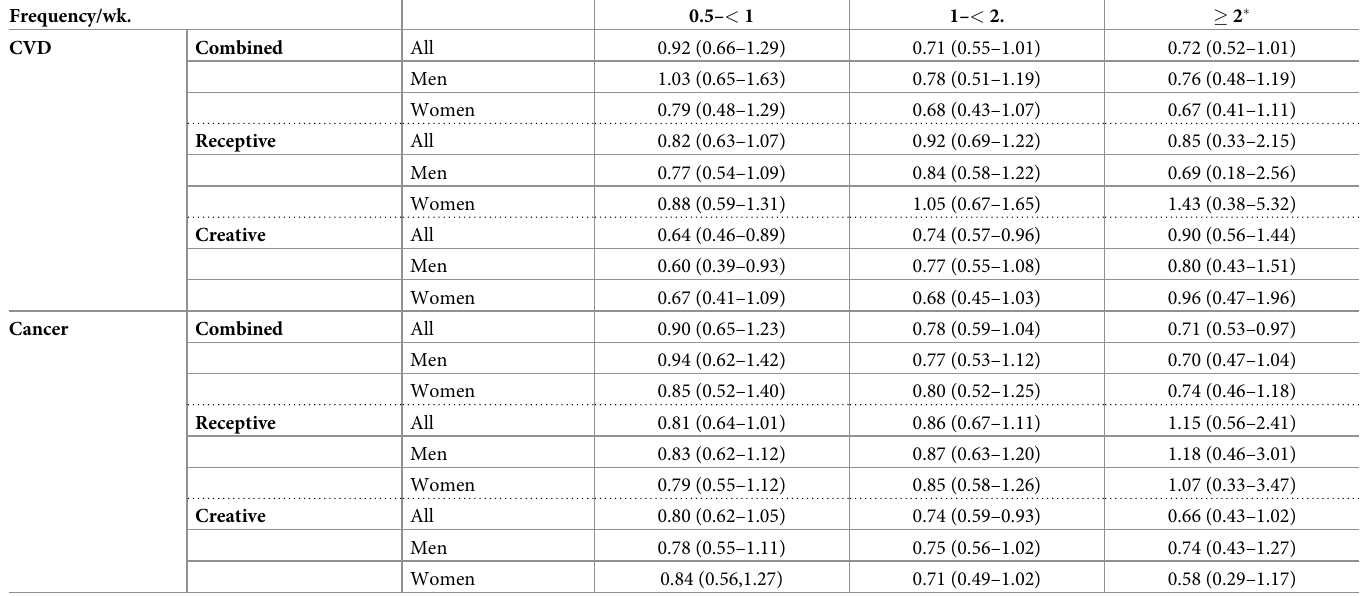
† Respective frequency max: four times/wk; creative frequency max: five times/wk; combined frequency max: nine times/wk. Fully adjusted ref.: never or